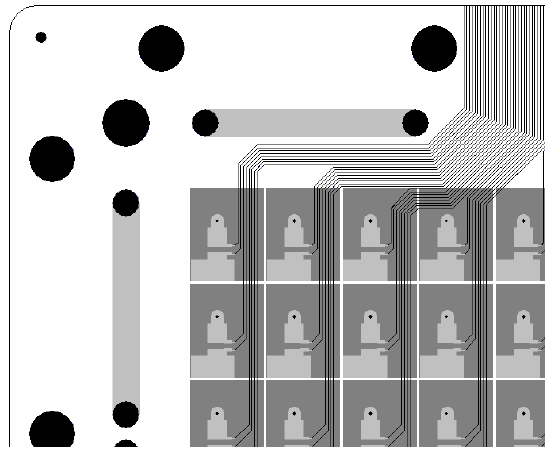
Figure 3. Part of a sensor device layout with borings and buried vias.